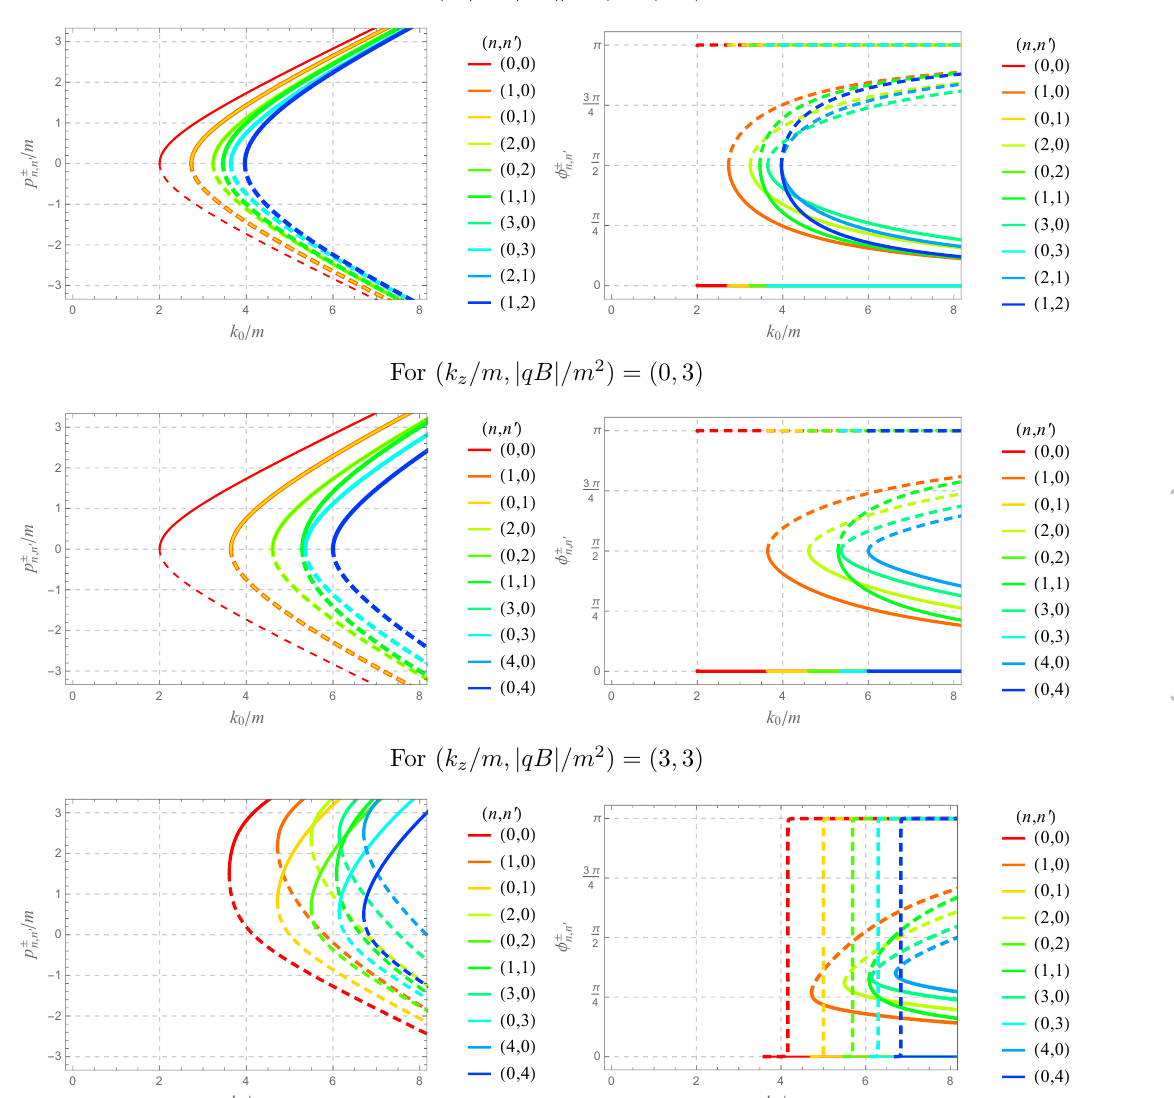
(left) and zenith angle φ ± (right) allowed for the di- Figure 2 . The longitudinal momentum p ± n,n 0 n,n 0 lepton to take, when converted from a photon carrying energy k and momentum k with parameter 0 z sets: ( k 2 ) = (0 , 1) [first row], (0 , 3) [second row], and (3 , 3) [third row]. Only the first z /m, | qB | /m ten pairs of Landau levels are shown in ascending order with respect to the threshold energy (4.4) from red (which is always the lowest Landau level pair n = n 0 = 0 ) to